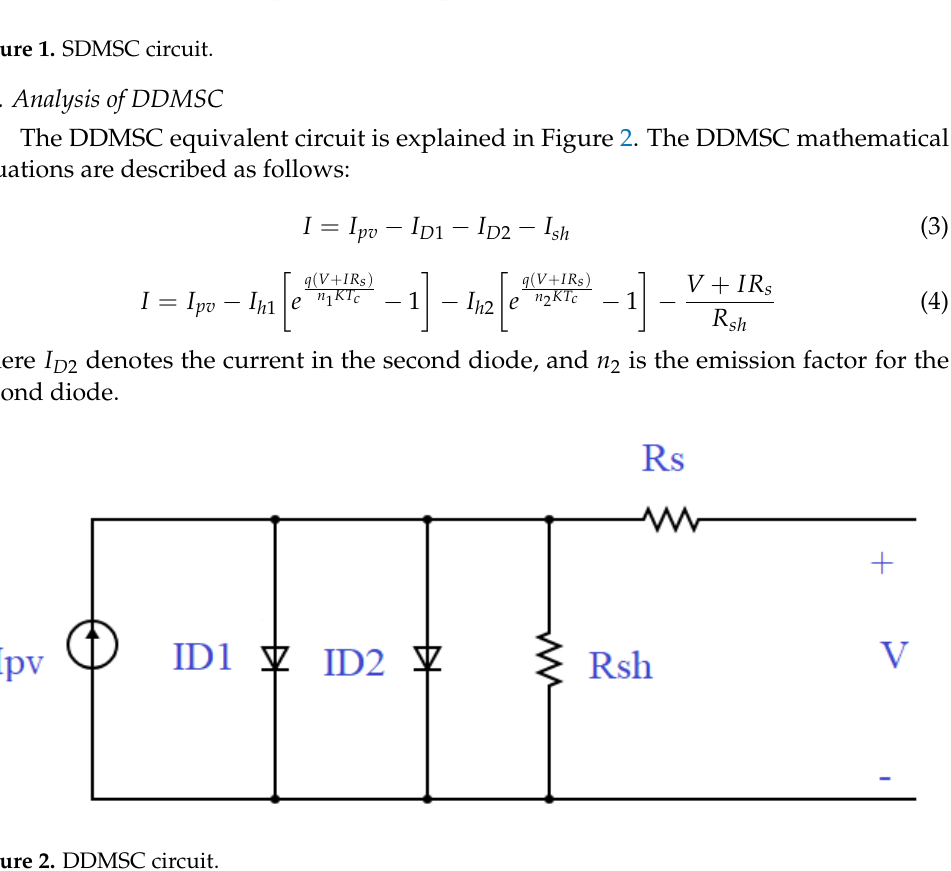
Figure 2. DDMSC circuit. Figure 2. DDMSC